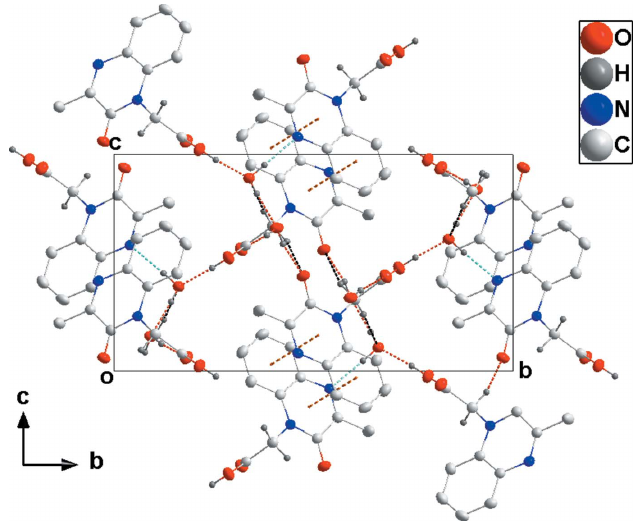
Figure 3 Packing diagram of the title compound viewed along the a axis with O— H (cid:2)(cid:2)(cid:2) O, O—H (cid:2)(cid:2)(cid:2) N and C—H (cid:2)(cid:2)(cid:2) O hydrogen bonds (Table 1) shown, respectively, as red, light-blue and black dashed lines. The (cid:2) – (cid:2) stacking interactions are shown as orange dashed lines